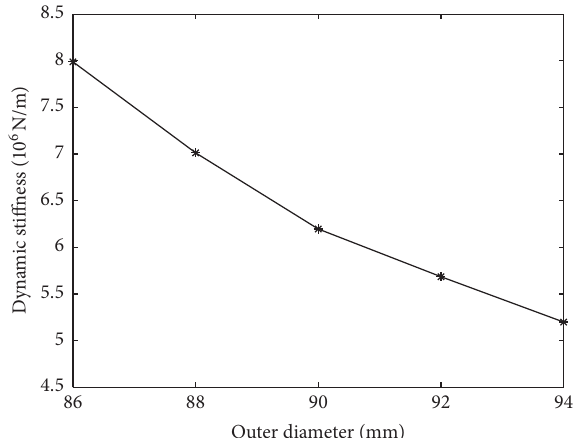
Figure 19: Influence of the variations in outer damping ring di- ameter on the dynamic